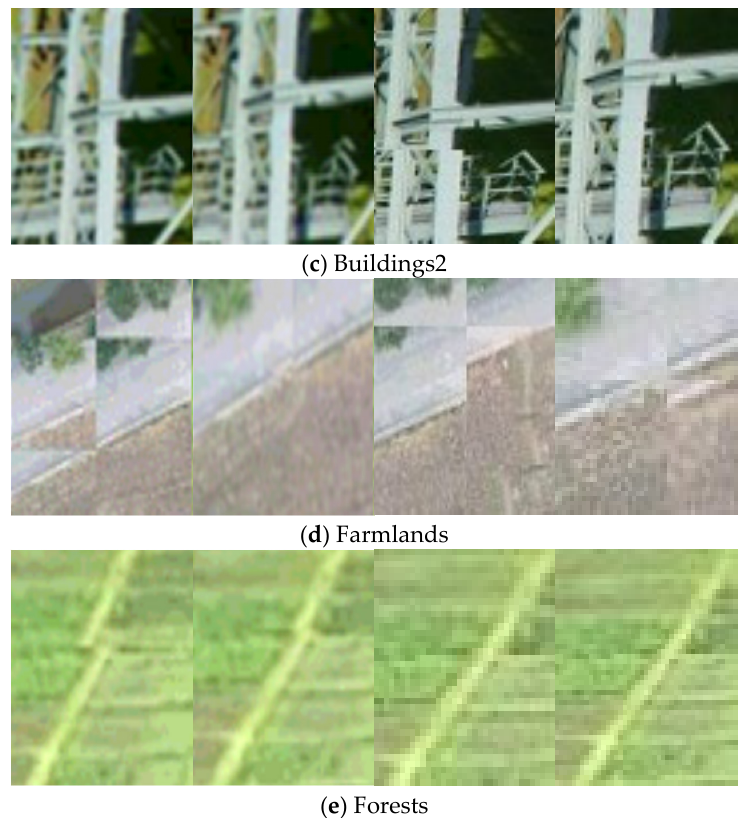
Figure 7. Some details in the checkerboard mosaicked images of five scenes obtained by four registration methods, and from left to right, they are VGG-16, DResNet-50, BResNet-50 and KResNet-50: ( a ) Urban, ( b ) Buildings1, ( c ) Buildings2, ( d ) Farmlands and ( e ) Forests.